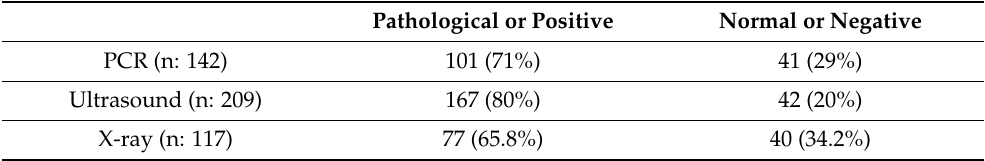
Table 1. Diagnostic test results. Pathological or Positive Normal or